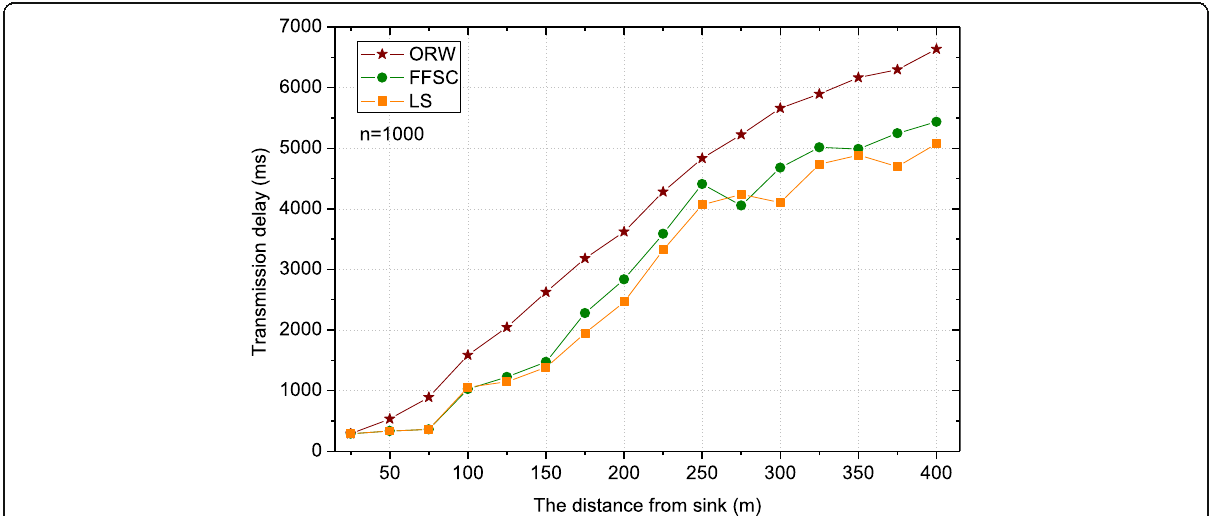
Fig. 21 The total delay under different distance from